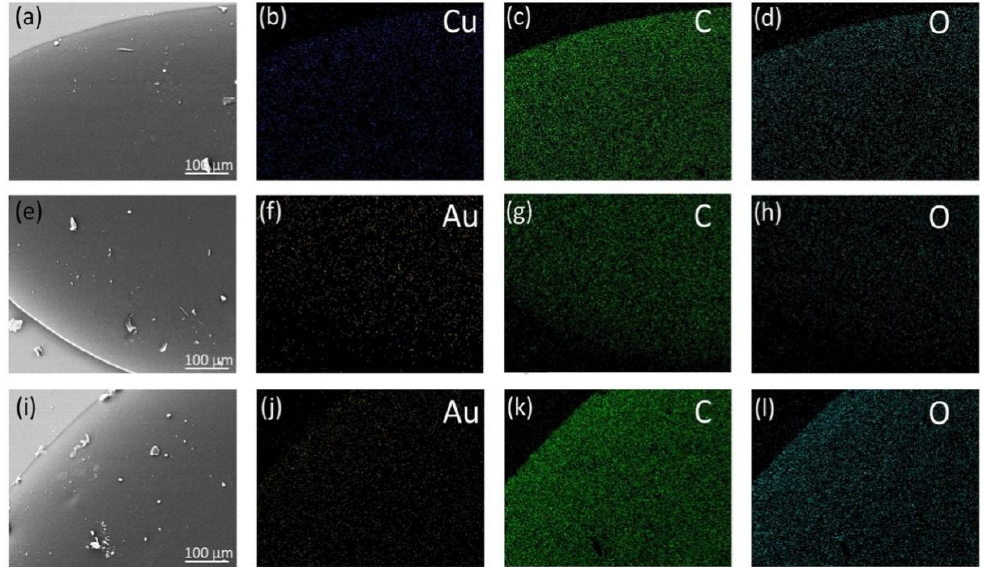
Figure 1. ( a ) SEM image and ( b – d ) SEM-EDS elemental mapping of Cu-MMI/PVA film, ( e ) SEM image and ( f – h ) SEM-EDS elemental mapping of Au-ATT/PVA film, and ( i ) SEM image and ( j – l ) SEM-EDS elemental mapping of Au-BSA/PVA